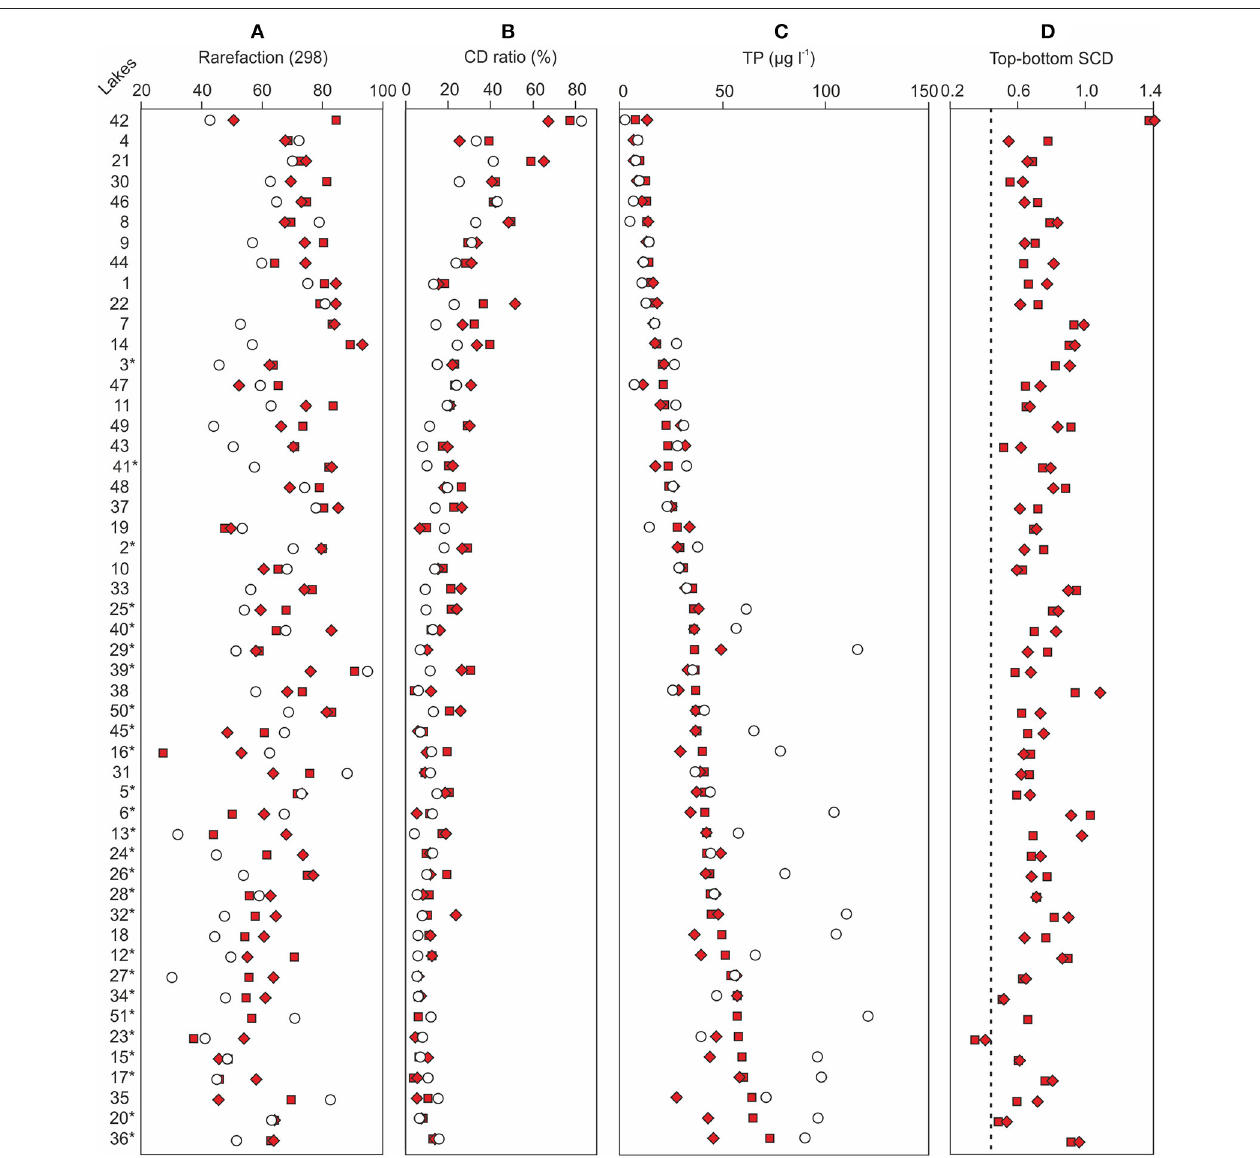
FIGURE 4 | A comparison between (A) the reconstructed bottom sample total phosphorus (TP) concentrations and the monitored modern TP concentrations of each sampling site, (B) bottom and top sample chrysophyte cyst to diatom (CD) ratios and (C) diatom species richness, and (D) bottom sample squared chord distances (SCDs) from the top samples. The filled squares denote the lower bottom samples, the filled diamonds denote the upper bottom samples, and the empty circles represent modern TP in (A) and top samples in (B–D) . The dashed vertical line in (D) represents the median SCD between the two bottom samples of each lake. The sampling sites are organized according to increasing bottom sample total phosphorus reconstructions. The Iisalmi Route sampling sites are marked with an asterisk. See Table 1 for the names and locations of the sampling sites and Tammelin et al. (2017) for the description of the top sample data.